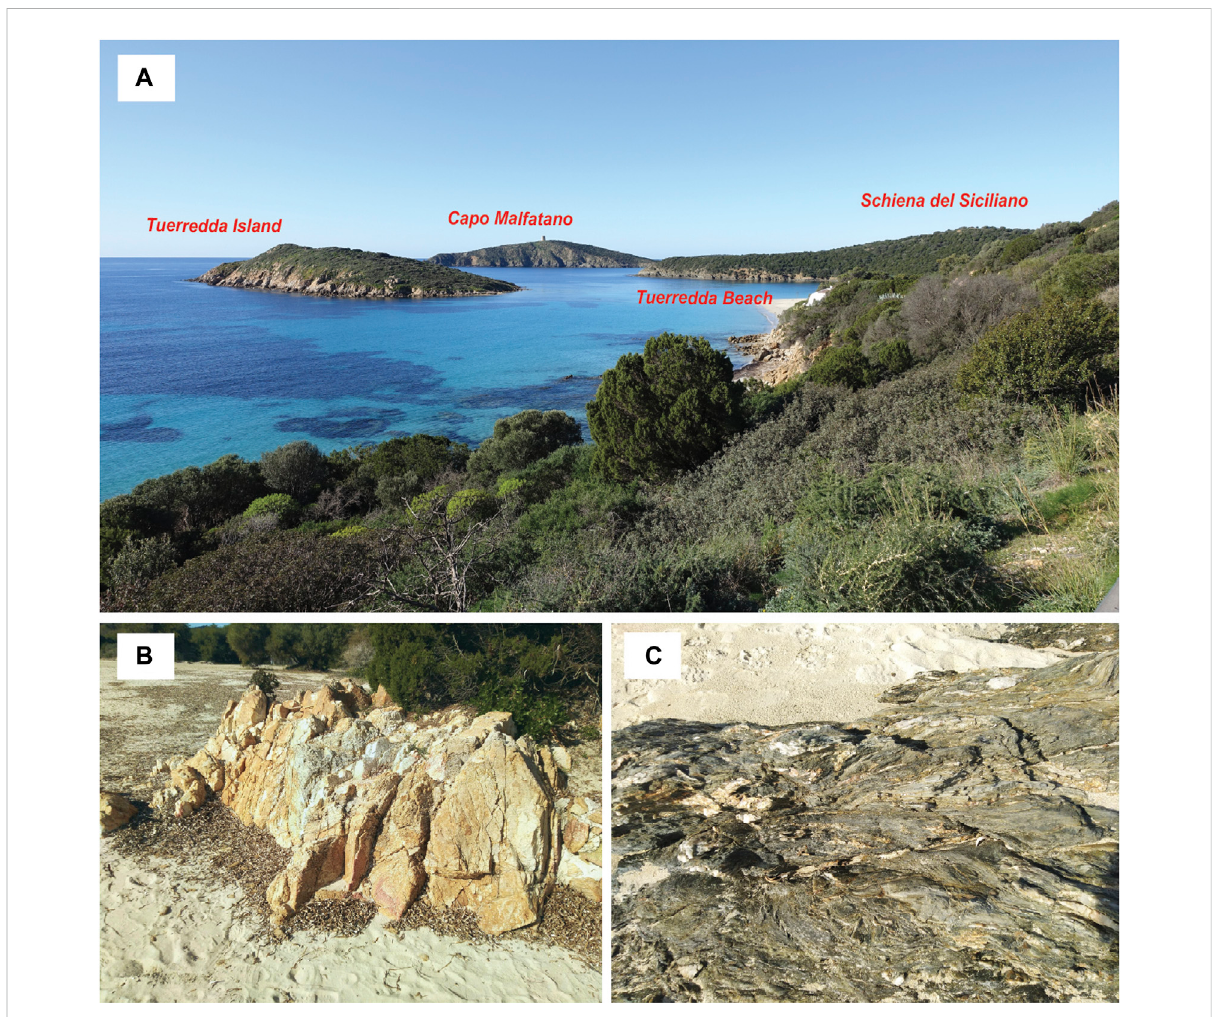
FIGURE 7 (A) View from the main road (toward SW) of the Tuerredda beach and island in the foreground and Capo Malfatano and Schiena del Siciliano headlands in the background; (B) outcrop of the Monte Filau orthogneiss in the eastern side of the Tuerredda beach; (C) outcrop of the highly deformed Bithia Unit phyllites in the western side of the Tuerredda